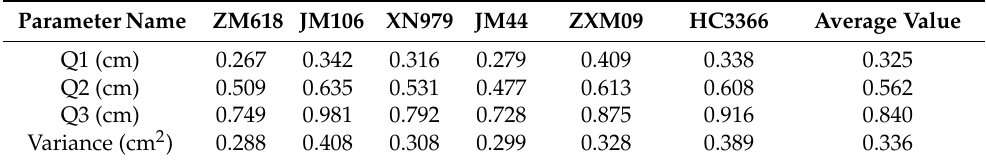
Figure 12. Box plot of the offset distance between the coordinate points of wheat leaf deformation results and the original 3D digitizing data. Table 5. The calculation results of offset distance between the coordinate points of wheat leaf deformation and the original 3D digitizing data.